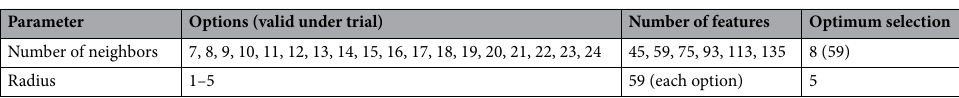
Table 12. Optimal parameters of LBP feature extraction module with cell size as 64 ×